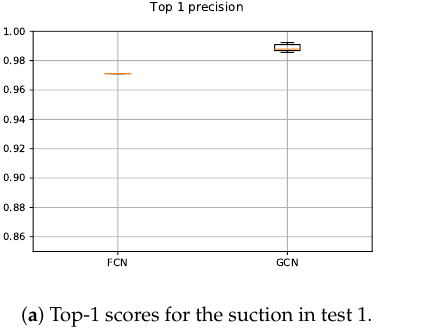
Figure 11. Obtained precision scores per confidence percentiles for the suction models in Test